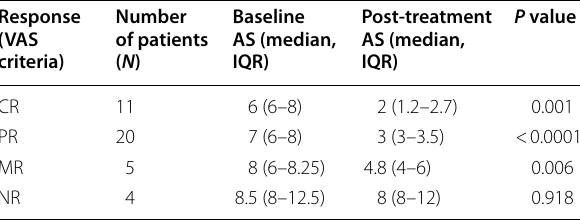
All the values are mentioned as median and inter-quartile range